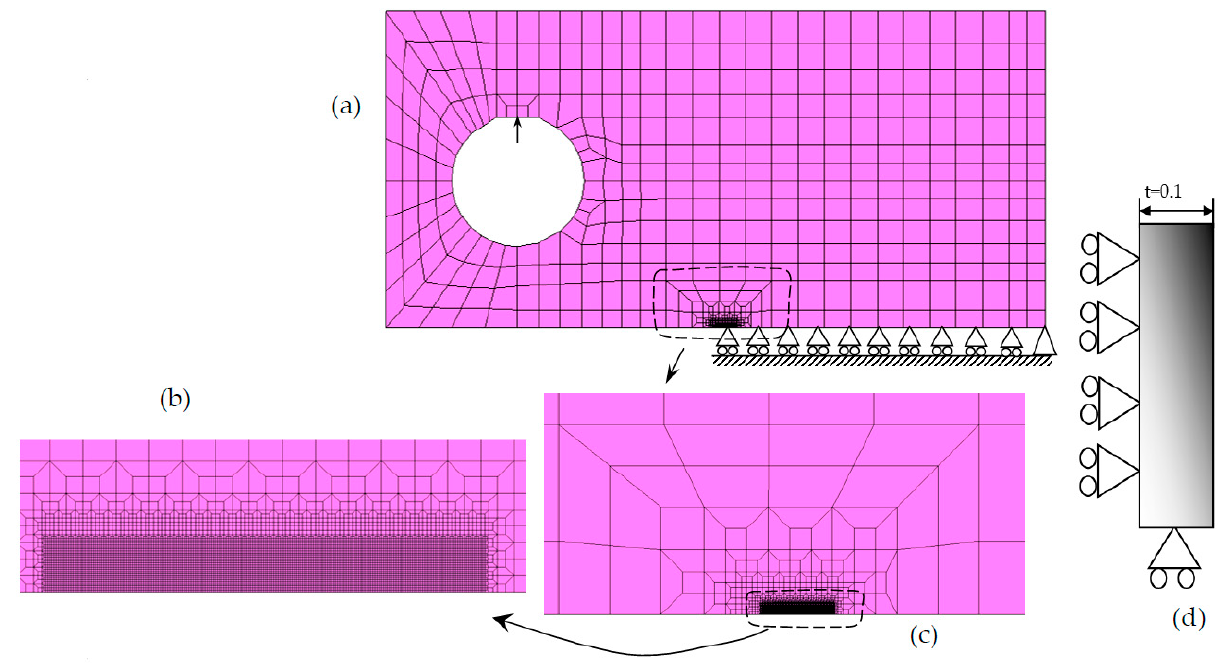
Figure 1. Model of C(T) specimen. ( a , d ) Load and boundary conditions. ( b , c ) Details of finite element mesh.